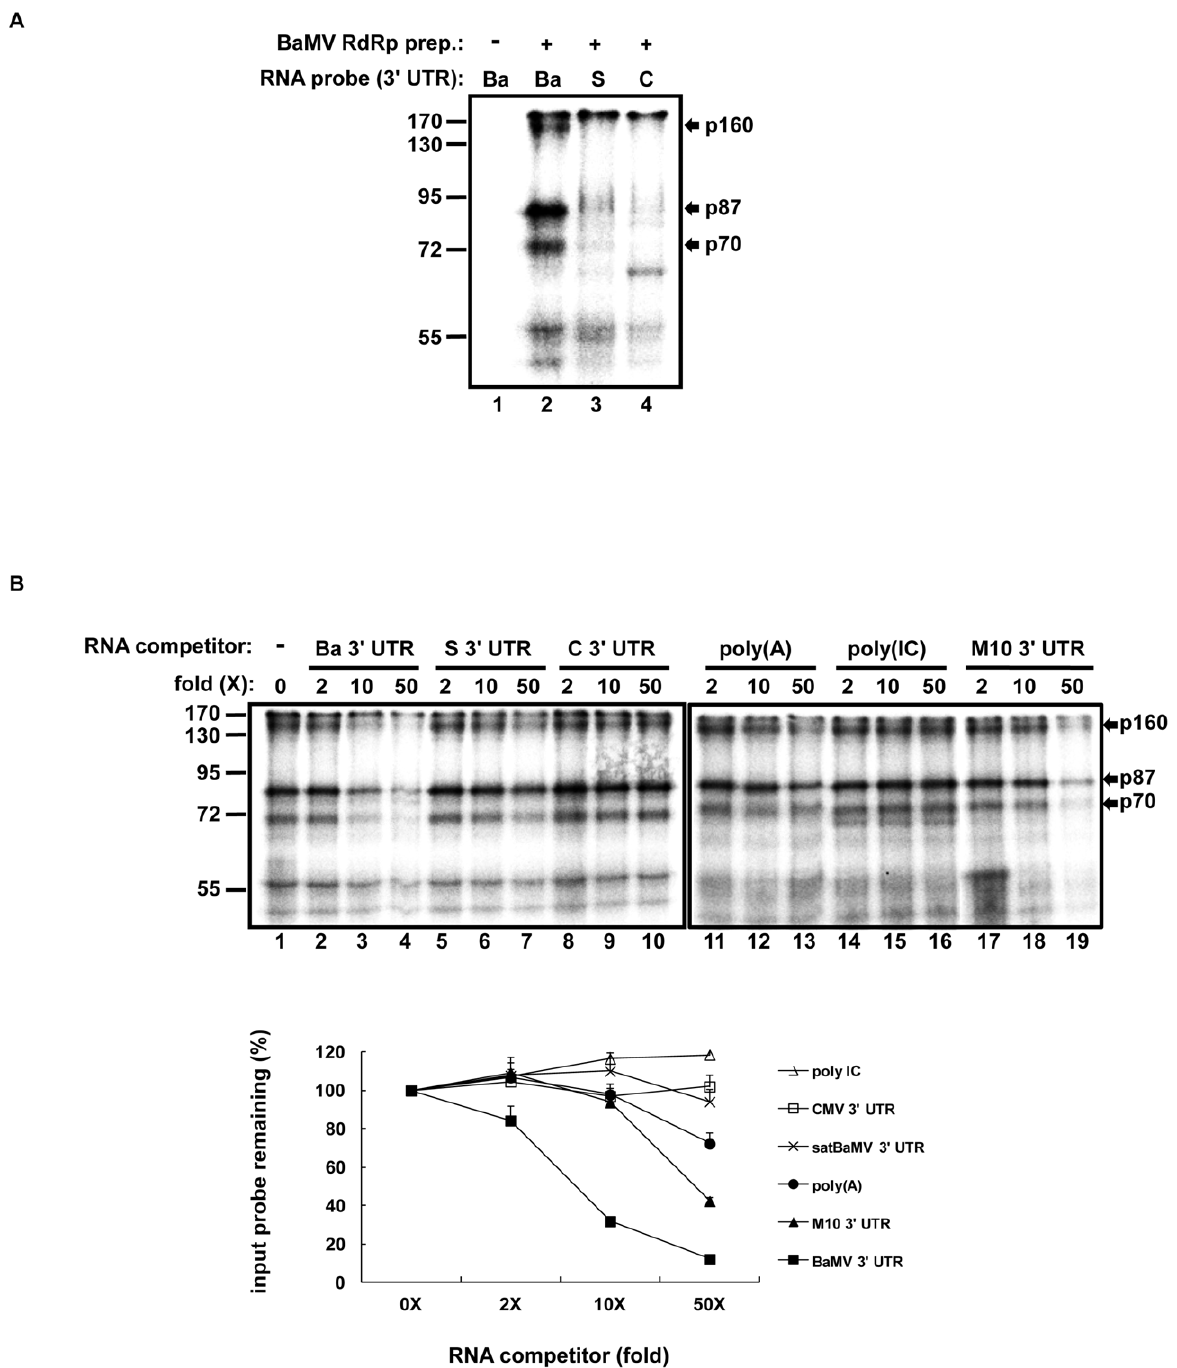
Figure 1. Identification of host factors that specifically interact with the BaMV 3 9 UTR in BaMV RdRp preparation. ( A ) Detection of host factors interacting with the 3 9 UTR of BaMV, satBaMV, or CMV by UV cross-linking assay. The BaMV (Ba), satBaMV (S), and CMV (C) 3 9 UTR probes were labeled with [ a - 32 P] UTP and individually incubated with the membrane fraction containing BaMV RdRp activity (BaMV RdRp prep.) purified from BaMV-infected N. benthamiana (lanes 2–4). The RNA-bound proteins were separated by electrophoresis on 10% SDS-polyacrylamide gels (PAG). In this experiment, the unbound RNA were digested away by RNase A and T1, leaving only a few 32 P-labeled nucleotides covalently linked to target proteins, which might slightly increase the molecular weight in the range of several kDa. Thus the relative molecular weights of the proteins were estimated by the mobility in the gel in comparison with pre-stained molecular weight markers, whose sizes (kDa) are indicated at the left of the panel. Arrows indicate the position of the candidate proteins, p160, p87, and p70, that interact with the BaMV 3 9 UTR in preference to the satBaMV and CMV 3 9 UTRs. ( B ) Characterization of binding specificity between the BaMV 3 9 UTR and candidate proteins by competitive UV cross-linking assay. BaMV RdRp prep. was incubated with the BaMV 3 9 UTR probe in the presence of 2-, 10-, and 50-fold molar excesses of unlabeled BaMV 3 9 UTR competitor (lanes 2–4), the satBaMV 3 9 UTR (lanes 5–7), the CMV 3 9 UTR (lanes 8–10), and the M10 3 9 UTR (lanes 17–19) and three, 15, and 75 ng of poly(A) (lanes 11–13) or poly(IC) (lanes 14–16) competitors. Bindings without competitors are indicated as ‘‘ 2 ’’ (lane 1). A quantification of band intensities